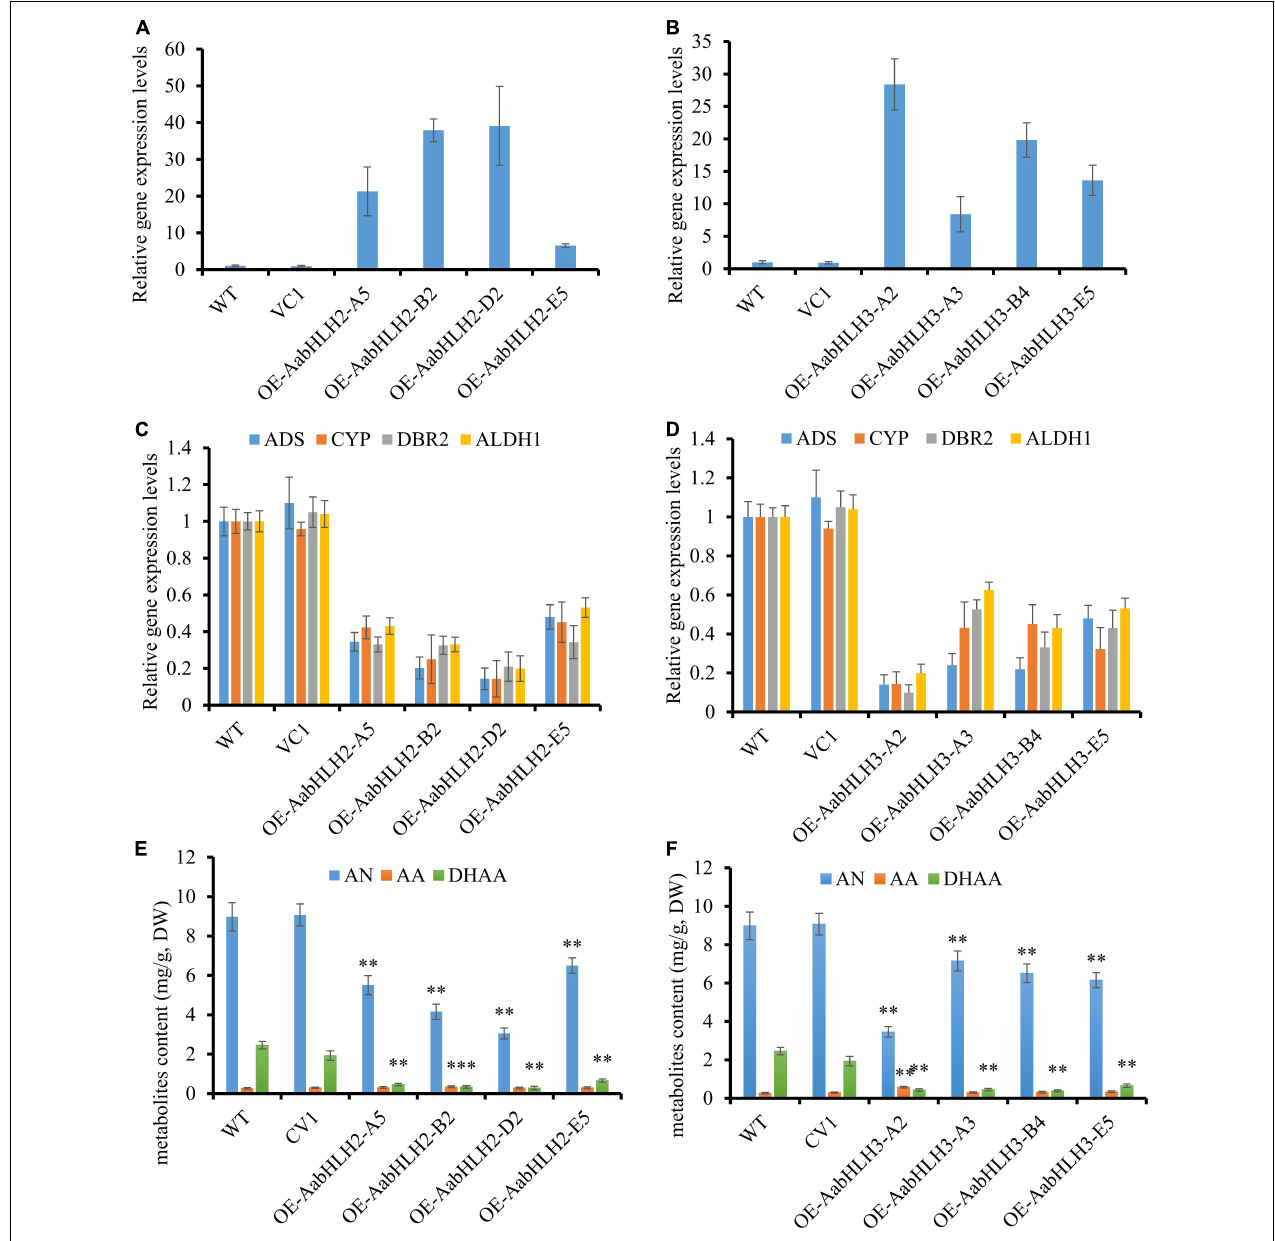
FIGURE 3 | Overexpressing of AabHLH2 and AabHLH3 affects artemisinin biosynthetic pathway gene expression levels and artemisinin-related metabolites contents. (A) Gene expression analysis of AabHLH2 in the AabHLH2 overexpressing transgenic plants. (B) Gene expression analysis of AabHLH3 in the AabHLH3 overexpressing transgenic plants. (C) Relative gene expression of ADS , CYP71AV1 , DBR2, and ALDH1 in the AabHLH2 overexpressing transgenic plants. (D) Relative gene expression of ADS , CYP71AV1 , DBR2, and ALDH1 in the AabHLH3 overexpressing transgenic plants. (E) The contents of artemisinin (AN), dihydroartemisinic acid (DHAA), and artemisinic acid (AA) in the AabHLH2 overexpressed plants and wild-type plants, determined by HPLC analysis. (F) The contents of artemisinin (AN), dihydroartemisinic acid (DHAA), and artemisinic acid (AA) in the AabHLH3 overexpressed plants and wild-type plants, determined